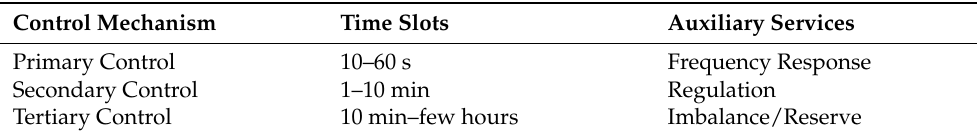
Table 1. Time Frames to Regulate Frequency in a Traditional Grid.